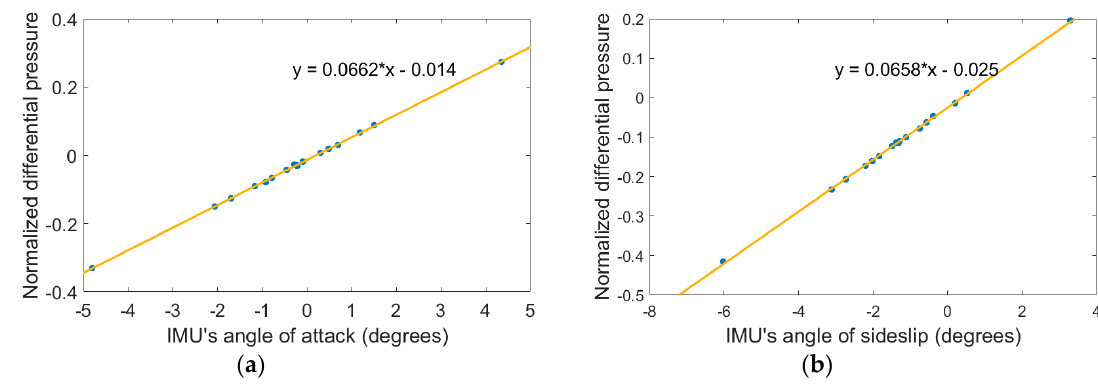
Figure 8. ( a ) Left plot: normalized differential pressure as a function of attack angle; and ( b ) right plot: normalized differential pressure as a function of sideslip angle.